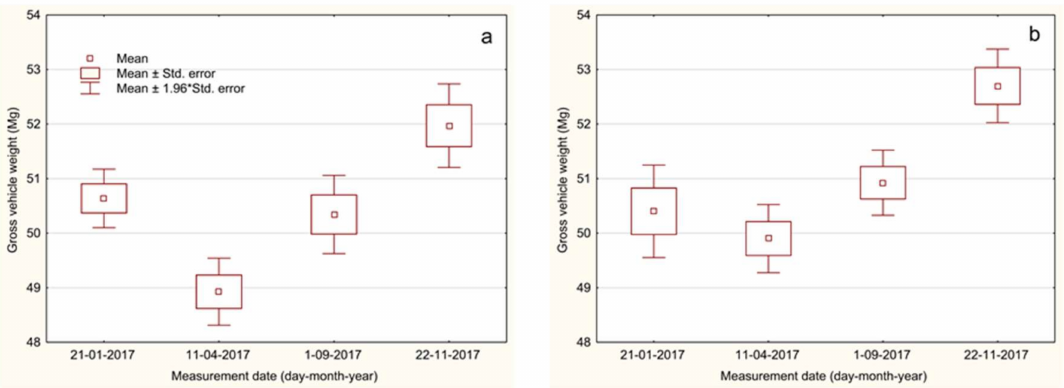
Figure 3. Comparison of average GVW values by measurement date for a unit with a semi-trailer ( a ) and a trailer ( b